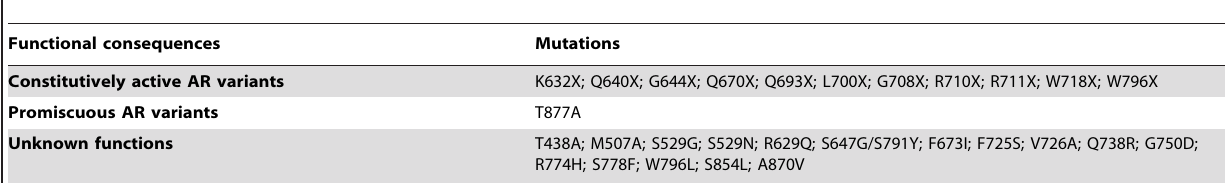
Table 1. Classification of androgen receptor mutations